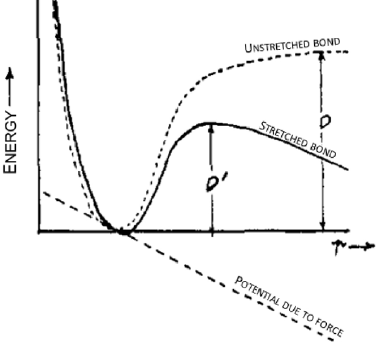
Fig. 12 Influence of applied force on the potential of a C-C polymer bond. Reproduced with permission from [14]. Copyright ACS,